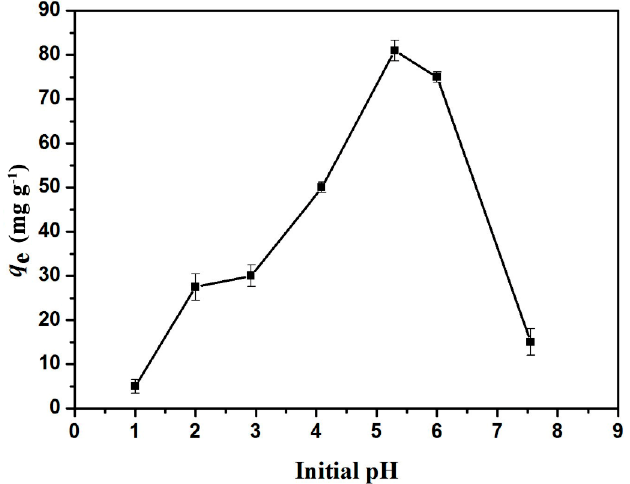
Figure 7. Effect of pH on the adsorption capacity. The error bars represent standard deviations based on three measurements.